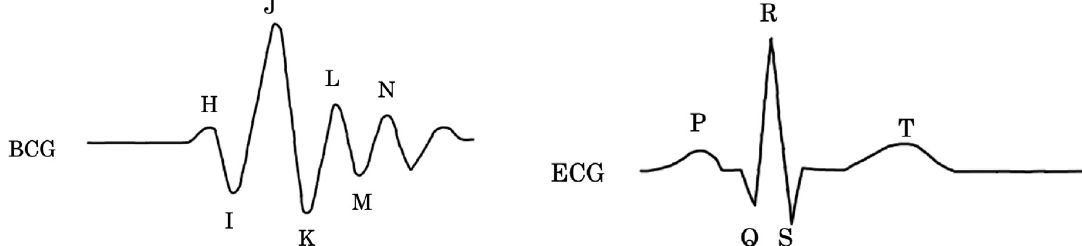
Fig 5. Sample BCG and ECG signals showing the correspondence between R-peaks and